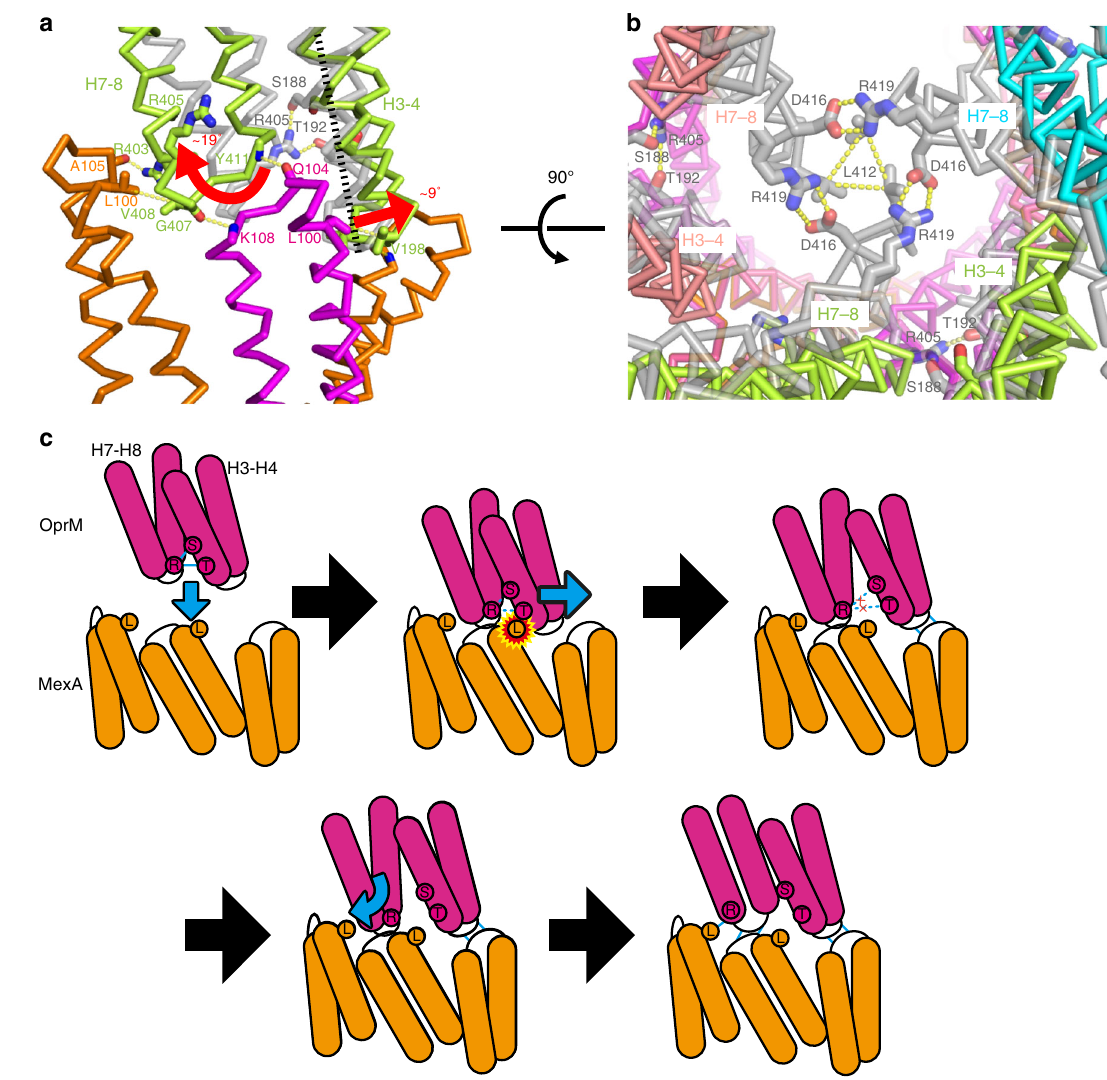
Fig. 4 A model of OprM channel opening. a , b Superposition of the OprM crystal structure (PDB ID: 3d5k, gray) and cryo-EM structure (0° state, colored according to Fig. 1) viewed from the periplasmic space ( a ) or from outside the cell ( b ). Red arrows indicate helix movements of H3 – H4 or H7 – H8 from the closed crystal structure to the open cryo-EM structure. c Schematic cartoon of the channel-opening mechanism of OprM. Enclosed letters with circles indicate critical residues for channel opening and complex formation: L indicates L100 in MexA, and S, T, and R indicate S188, T192, and R405 in OprM,